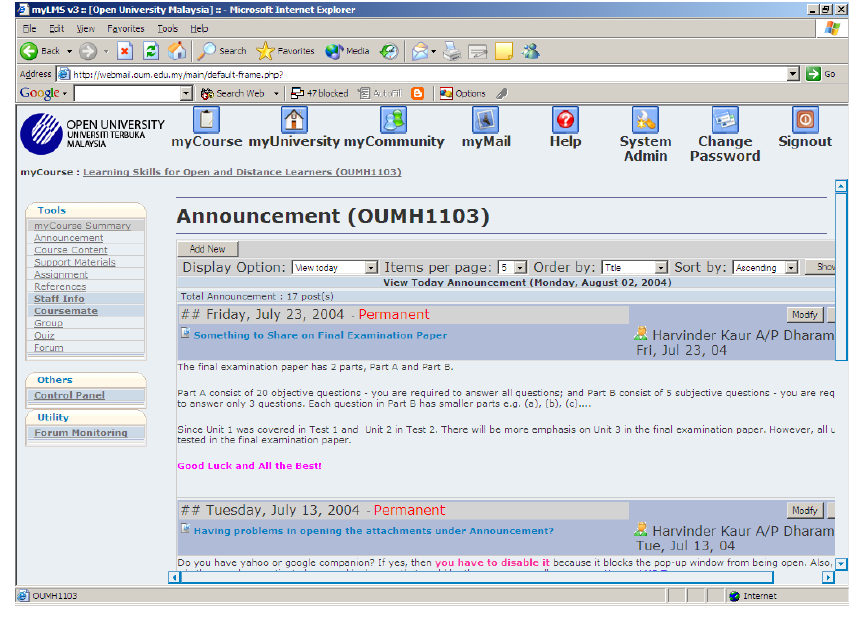
Figure 2: The Entry Page of